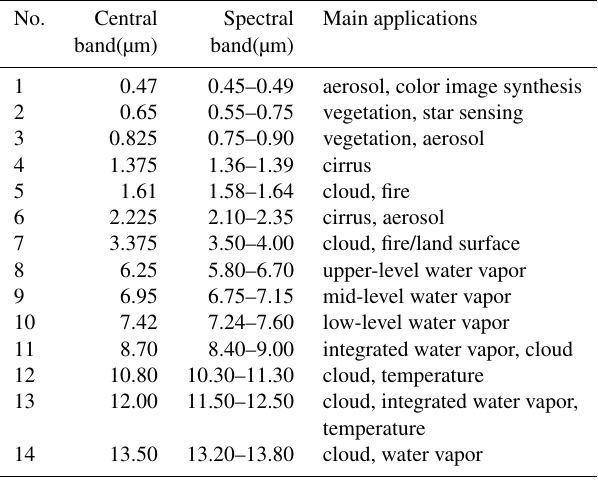
Table 4. Main parameters of